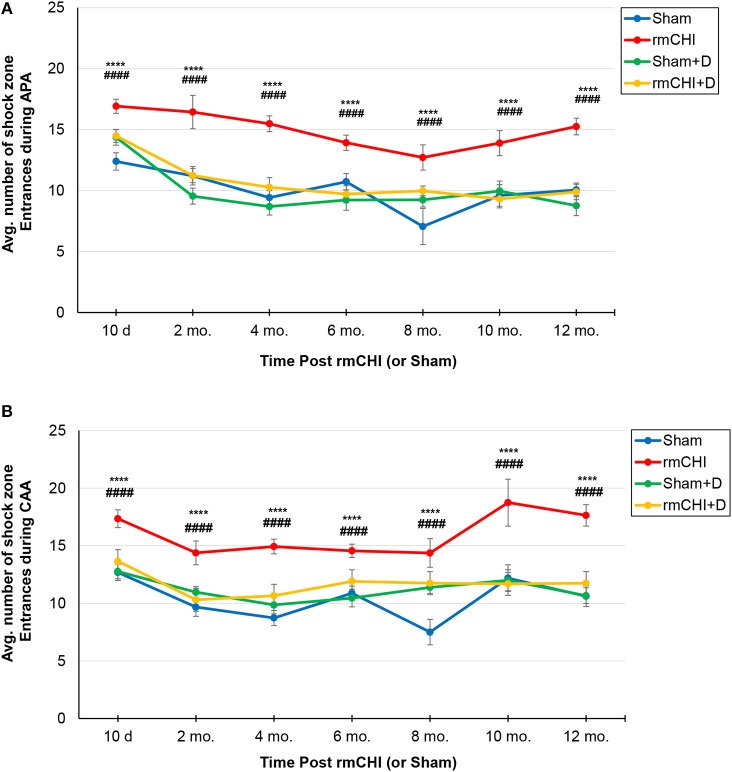
Assessment of cognitive deficits in TghTau/PS1 mice (with and without therapeutic intervention) post rmCHI (or sham). TghTau/PS1 mice were subjected to rmCHI (or sham treated) and evaluated for cognitive changes beginning at 10 days (d) following completion of the repetitive impact protocol and continuing throughout the 12 month (mo.) study. Mice were evaluated at each time point by APA (A) and CAA (B) as described in the Methods section and the average number of entrances into the shock zone were recorded. For drug studies (D), a combination of LiCl+ros was used. The data was evaluated using two-way ANOVA with Tukey's post-hoc test and presented as the mean ± SEM. *Indicates significantly different from sham (****p < 0.0001). #Indicates significantly different from rmCHI+drug (D) (####p < 0.0001).